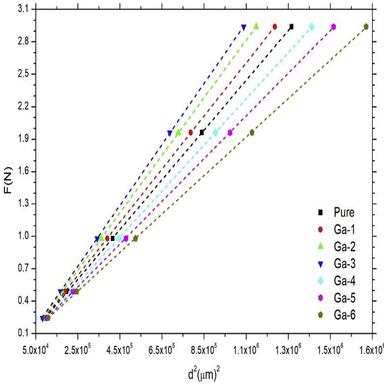
Plots between the applied indentation test load F1/2 and diagonal length d2 for the pure and Ga substituted Bi-site Bi-2212 materials.